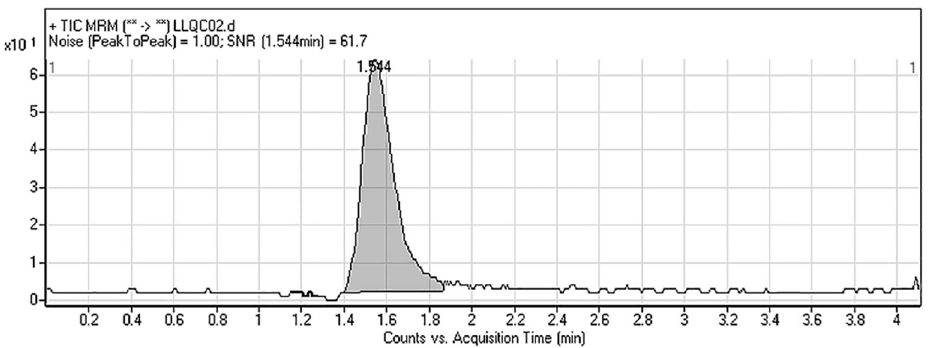
Fig 5. DMB LLQC MRM chromatogram revealing high S/N